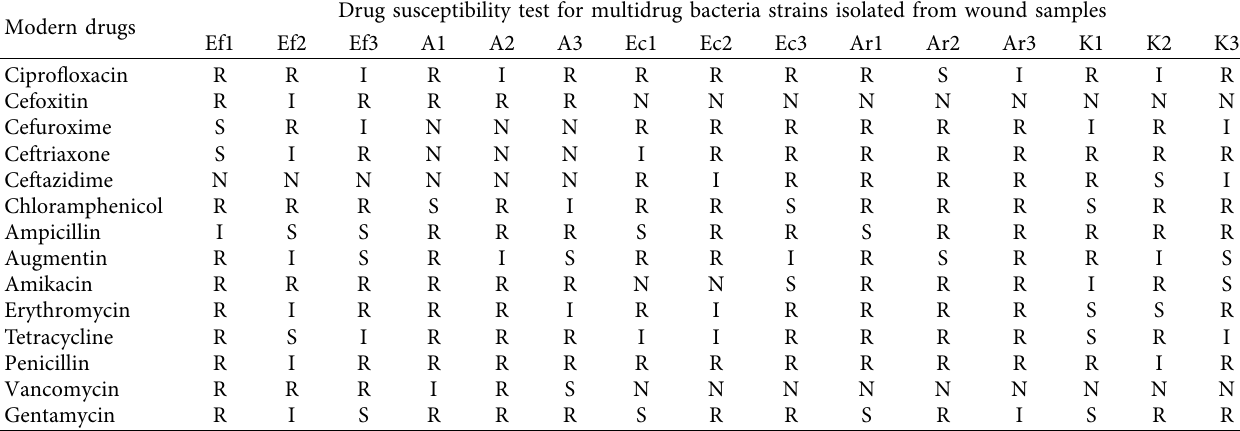
Table 1: Antibiotics resistant profile of multidrug-resistant bacteria isolated from wounds at KMU, 2020. Modern drugs